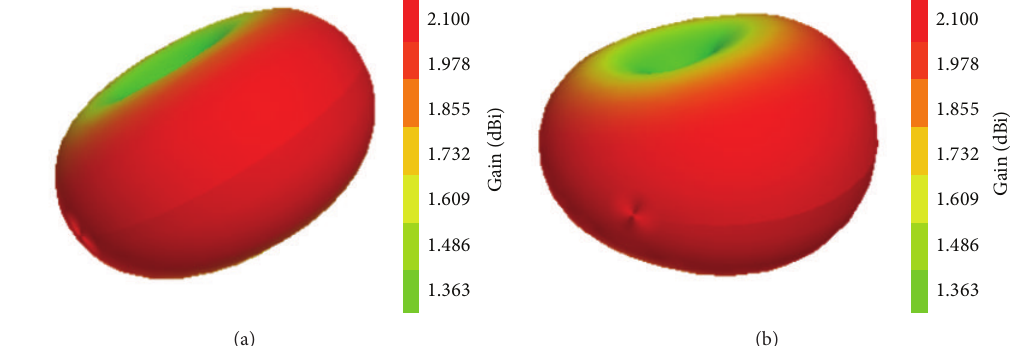
Figure 7: Three-dimensional radiation patterns of the proposed antenna at (a) the first band at 2.4 GHz and (b) the second band at 5.6